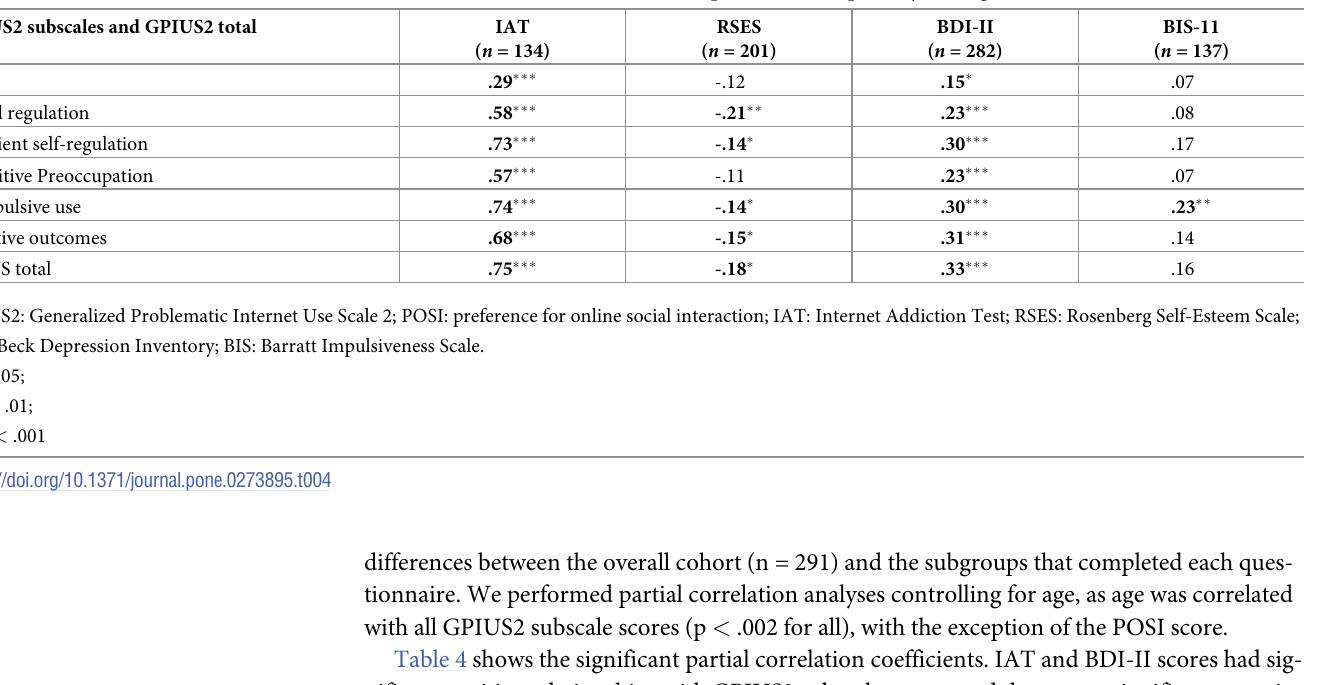
differences between the overall cohort (n = 291) and the subgroups that completed each ques- tionnaire. We performed partial correlation analyses controlling for age, as age was correlated with all GPIUS2 subscale scores (p < .002 for all), with the exception of the POSI score. Table 4 shows the significant partial correlation coefficients. IAT and BDI-II scores had sig- nificant positive relationships with GPIUS2 subscale scores, and there were significant negative relationships between RSES and GPIUS2 subscale scores. BIS-11 scores had significant positive relationships only with the compulsive use subscale scores. Similar results were observed after listwise deletion ( n = 128, S1 Table). Analysis of the theoretical model. After validating the measurement model, we tested the cognitive-behavioural model of Caplan ([18], Fig 1) using SEM (the second step of the two- step analysis procedure, [29]). Fig 4 shows the estimated standardized beta coefficients.